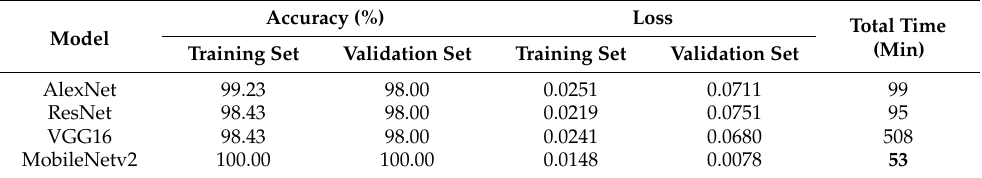
Table 9. Train results for vehicle speed identification of different models after 50 epochs.